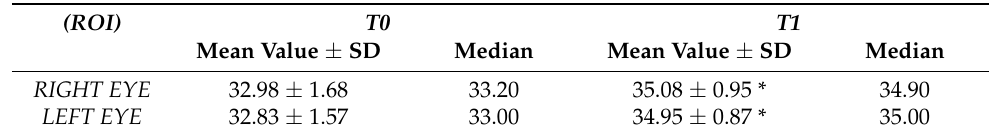
Table 2. Eye temperature: mean value ± SD and median obtained in T0 and T1 in the entire group. All values are expressed in °C. Data in T1 were significantly increased (*).